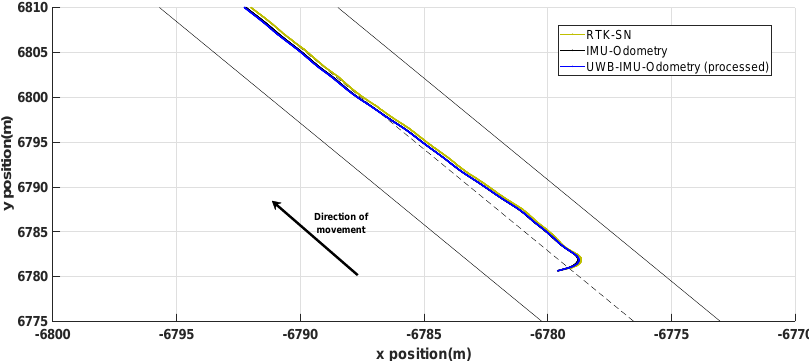
Figure 13. Comparison of the different trajectories at the beginning of the